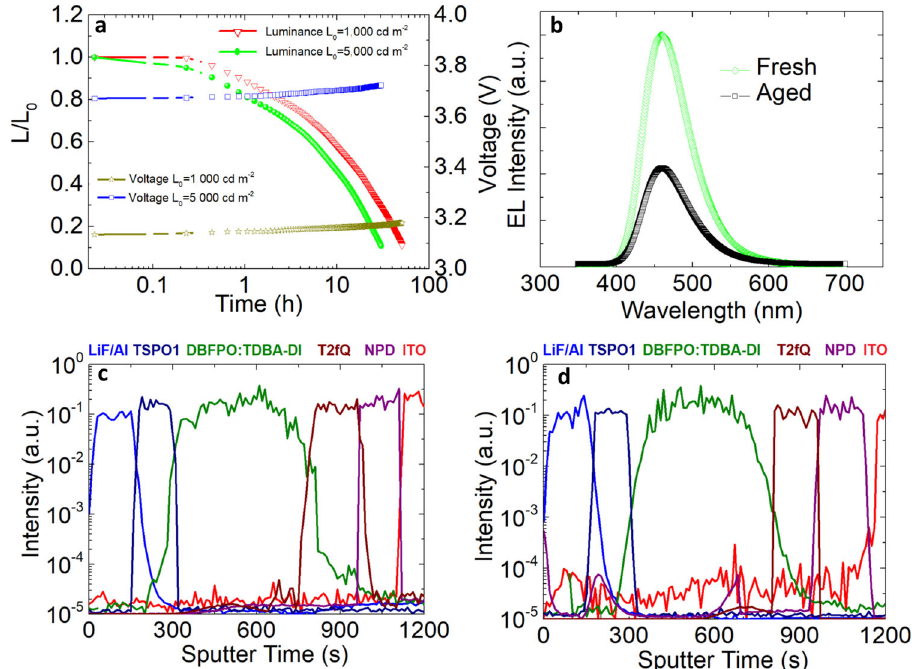
Fig. 5 Lifetime measurements. a Variation of normalized luminance vs. time and driving voltage vs. time for initial luminance of 1000 or 5000 cd m − 2 . b Electroluminescence spectra of the fresh and degraded device. TOF-SIMS pro fi les of the c fresh and d degraded OLED stack: the x -axis represents the materials depth distribution starting with the cathode interface from data point 0 and reaching to the ITO anode